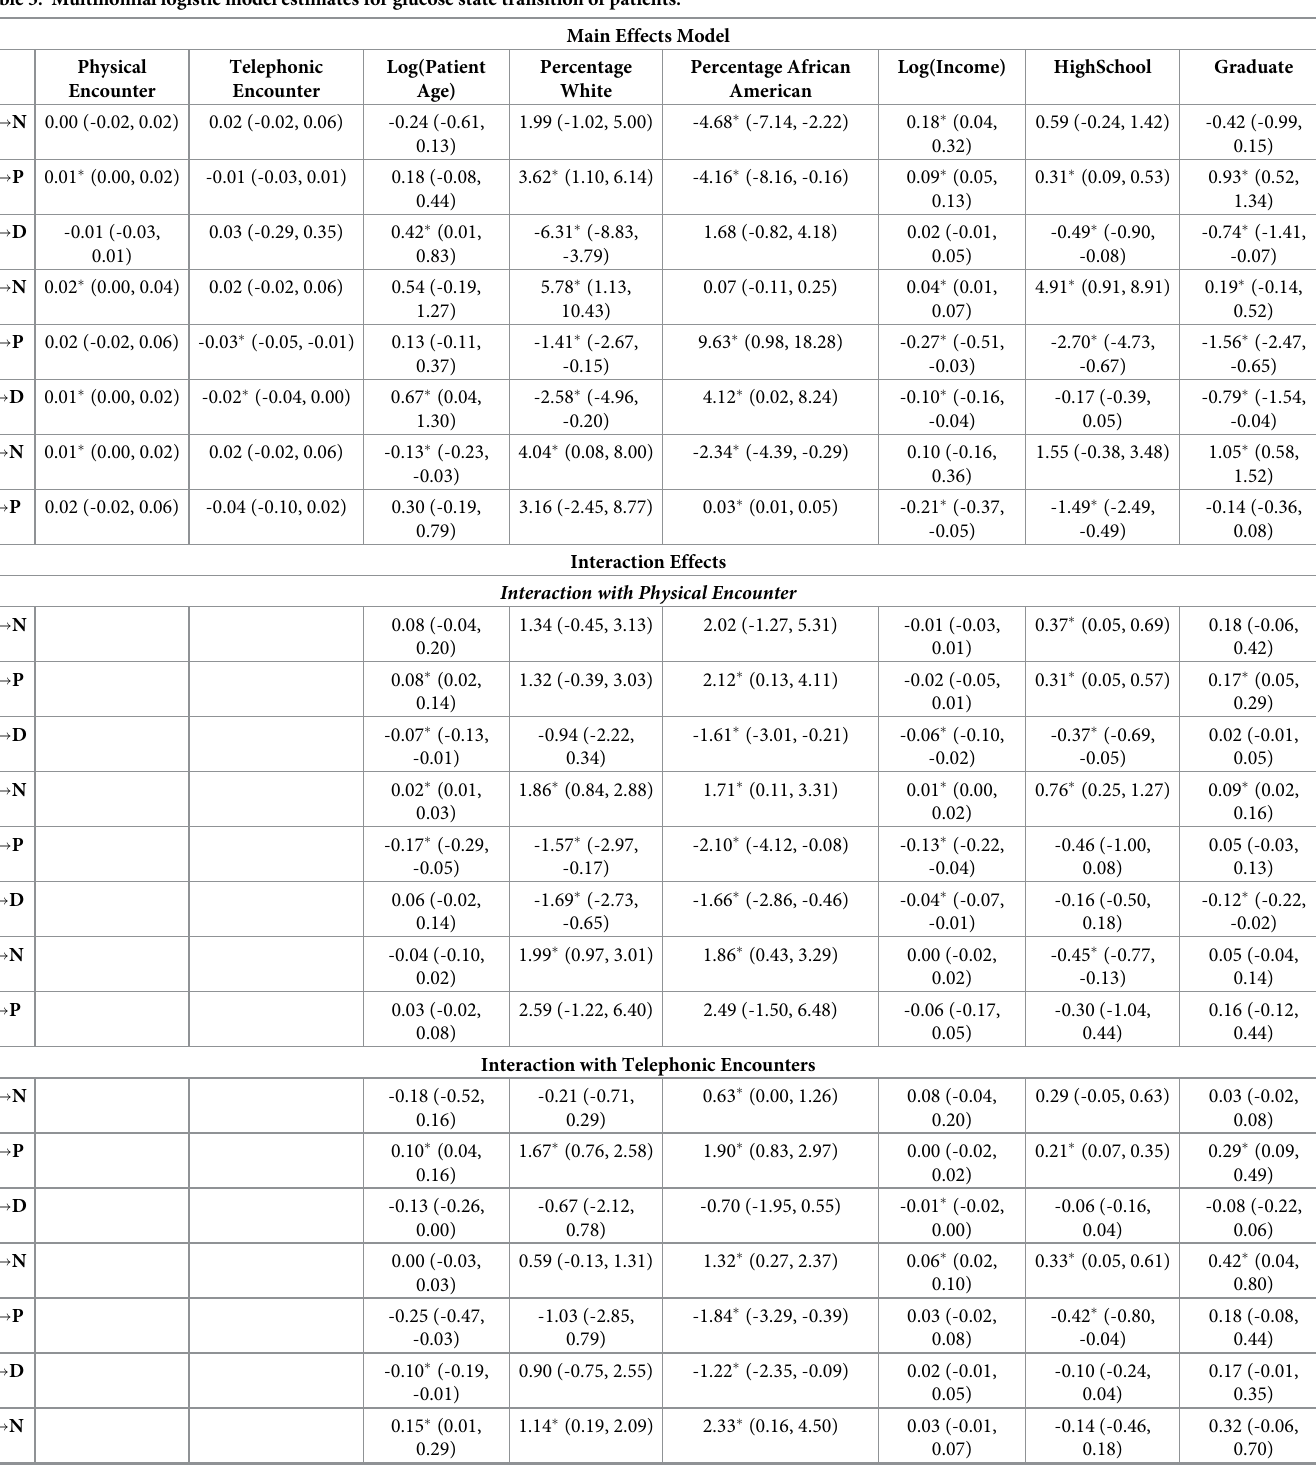
Table 3. Multinomial logistic model estimates for glucose state transition of